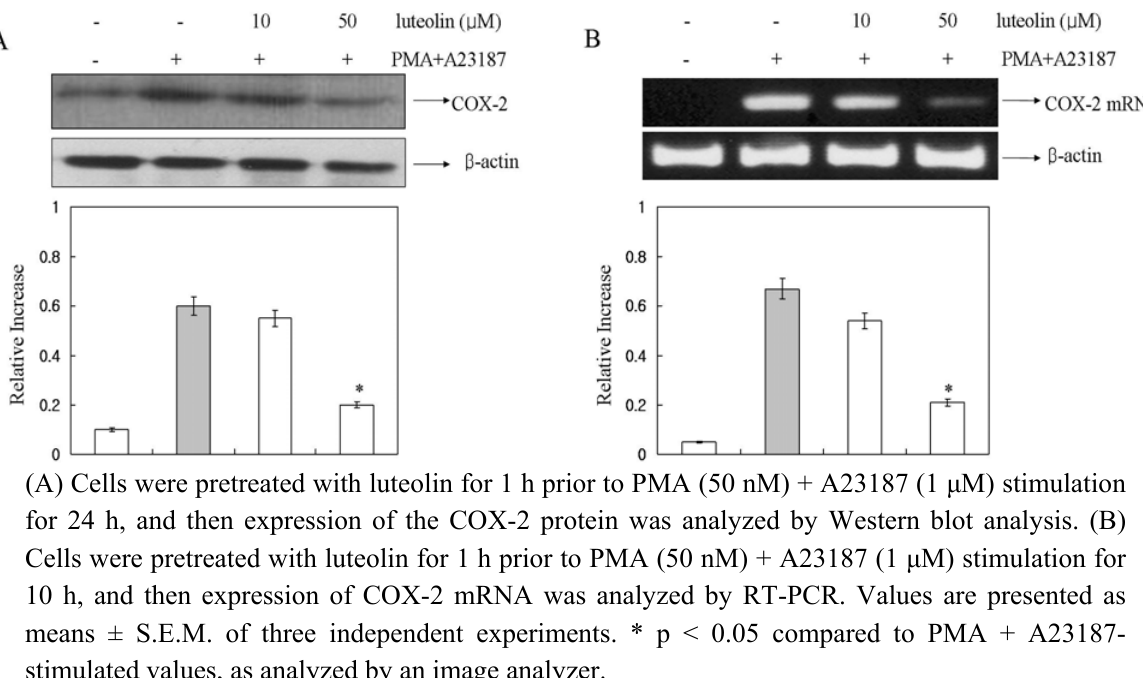
Figure 3. Effect of luteolin on COX-2 protein and mRNA expression in PMA plus A23187-induced HMC-1